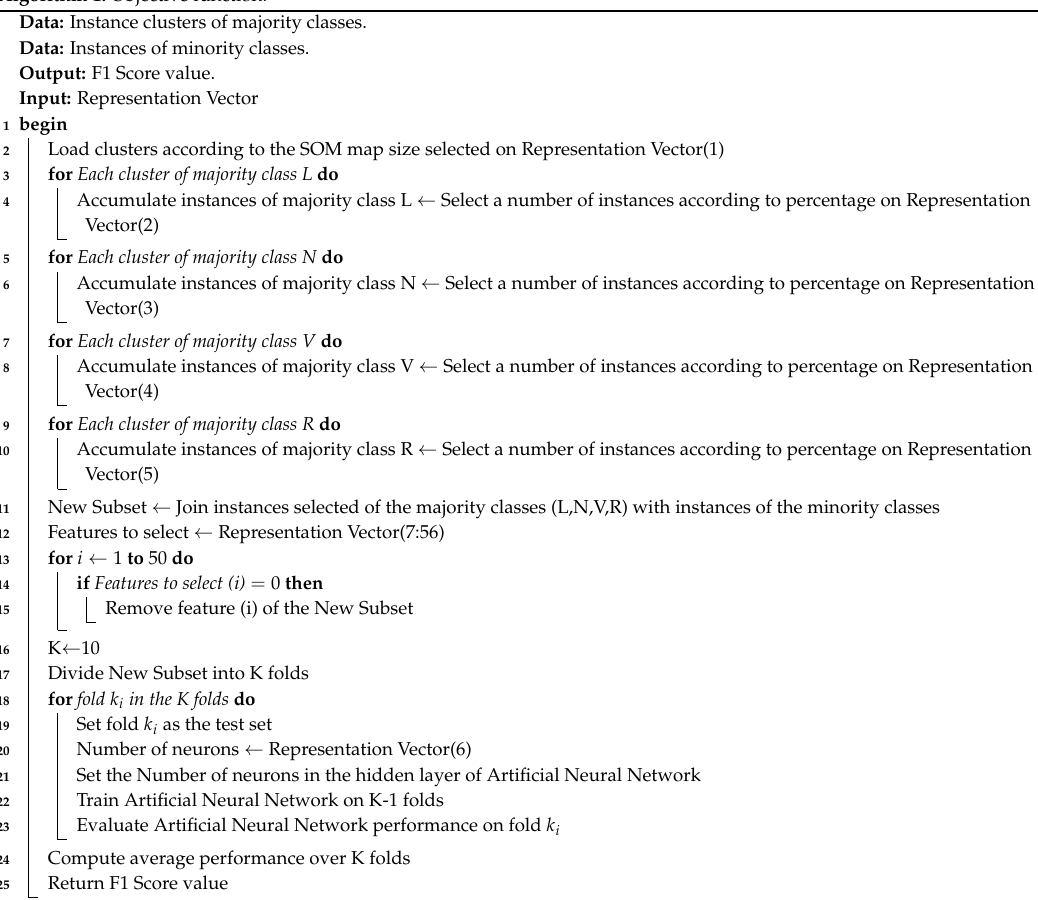
Algorithm 1: Objective